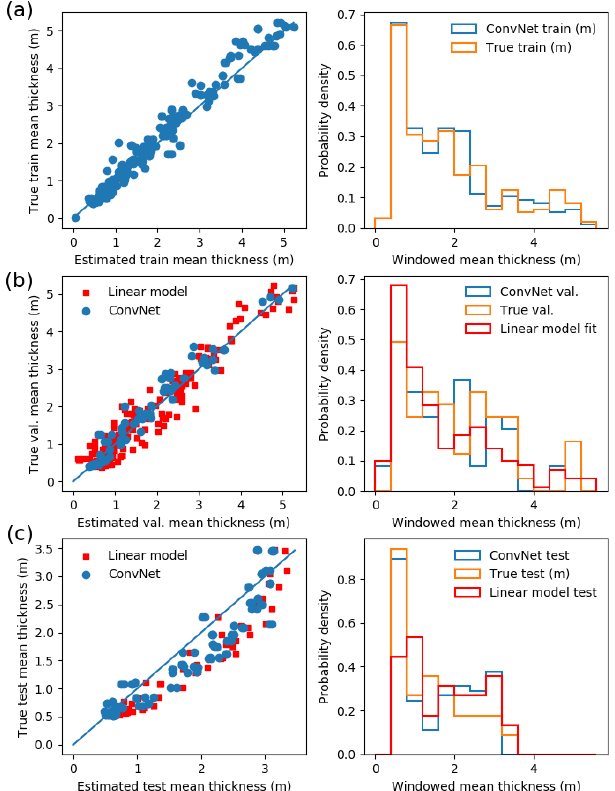
Figure 8. ConvNet results, with (a) the learned ConvNet model ap- plied to the training data (80% of randomly sampled 20m × 20m windows from PIP4, PIP7, PIP9), with MRE 12%; (b) the learned ConvNet model applied to the validation data (remaining 20% of the randomly sampled 20m × 20m windows from PIP4, PIP7 and PIP9) with a MRE of 16% as well as a linear model (with snow freeboard + constant) fitted to PIP4, PIP7 and PIP9 with a MRE of 25%; (c) the learned ConvNet model and fitted linear model ap- plied to randomly sampled 20m × 20m windows from PIP8, as a check against learning self-similarity, with MREs of 20% (Con- vNet) and 32% (linear model)). In each case, the left panel shows a scatter plot with the predicted and true thicknesses, and the right panel shows the resulting thickness distribution. Our results suggest slight overfitting, as the test error is higher than the training error, but the learned model still generalizes fairly well, with MREs much lower than linear models, even when including an unphysical inter- cept to improve the fit (Table